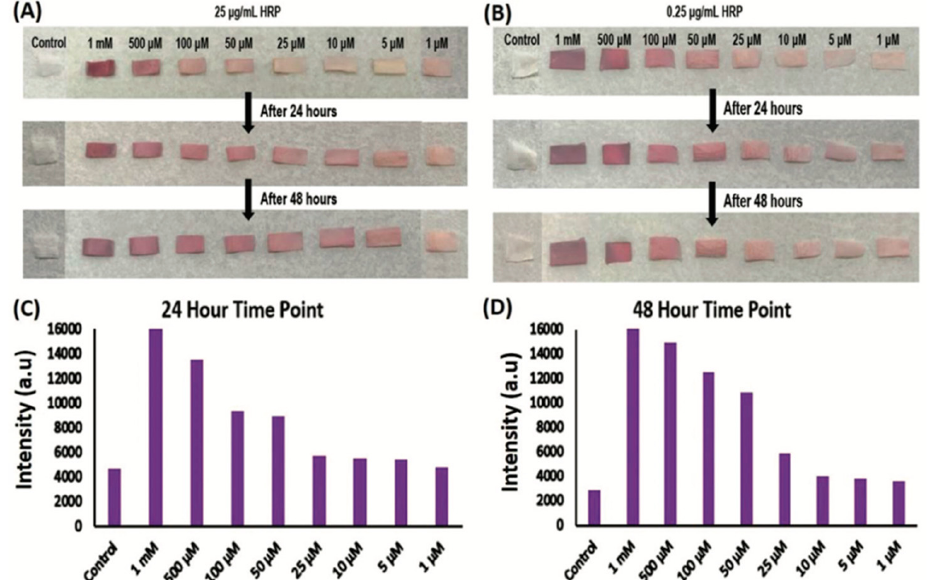
Figure 3. SF mats and control mats with Amplex red after treatment with known concentrations of HRP and hydrogen peroxide. ( A ) Fixed HRP concentration of 25 µg mL − 1 and differing H 2 O 2 concentrations at 24 and 48 h time points. ( B ) Fixed HRP concentration of 0.25 µg mL − 1 and differing H 2 O 2 concentrations at 24 and 48 h time points. ( C ) Colorimetric quantitation of intensity at 24 h time point. ( D ) Colorimetric quantitation of intensity at 24 h time point. Reprinted with permission from Ref. [87]. 2020 Biomaterials Science.